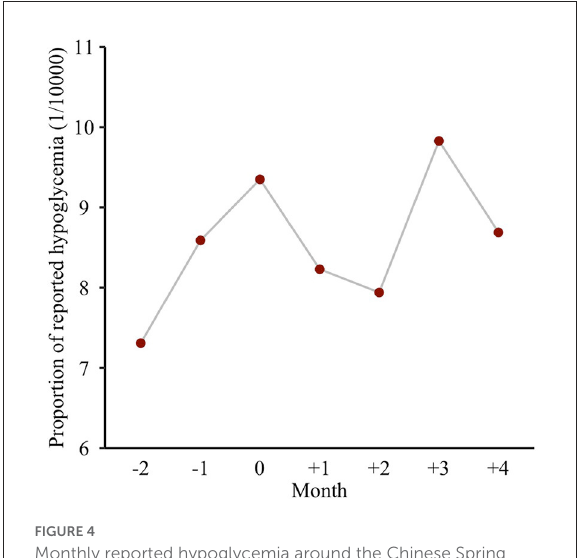
FIGURE4 Monthly reported hypoglycemia around the Chinese Spring